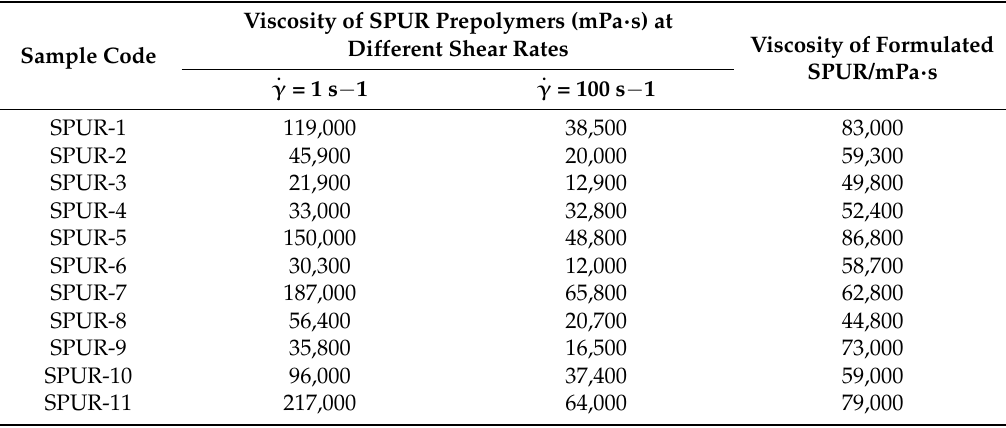
Table 7. Viscosities of SPUR prepolymers and their formulations at various shear